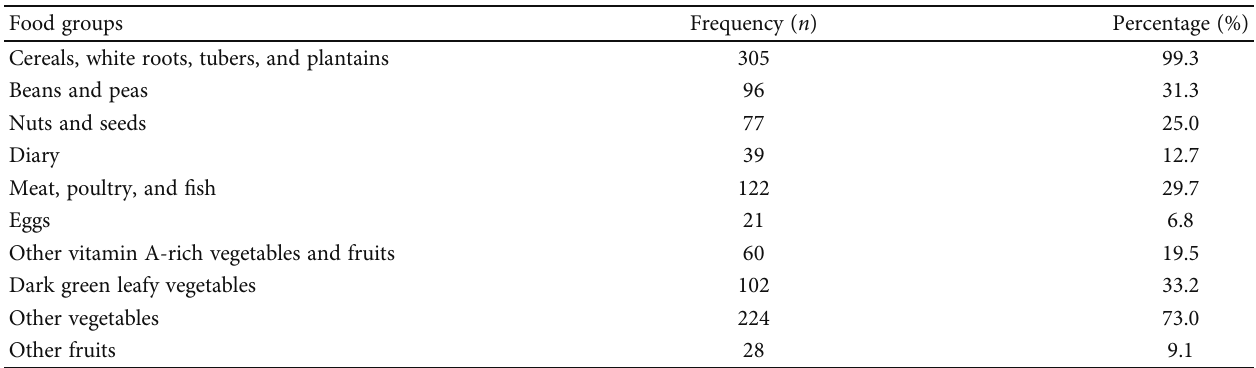
Table 4: Proportion of di ff erent food groups consumed by the children within 24hours prior to the survey.